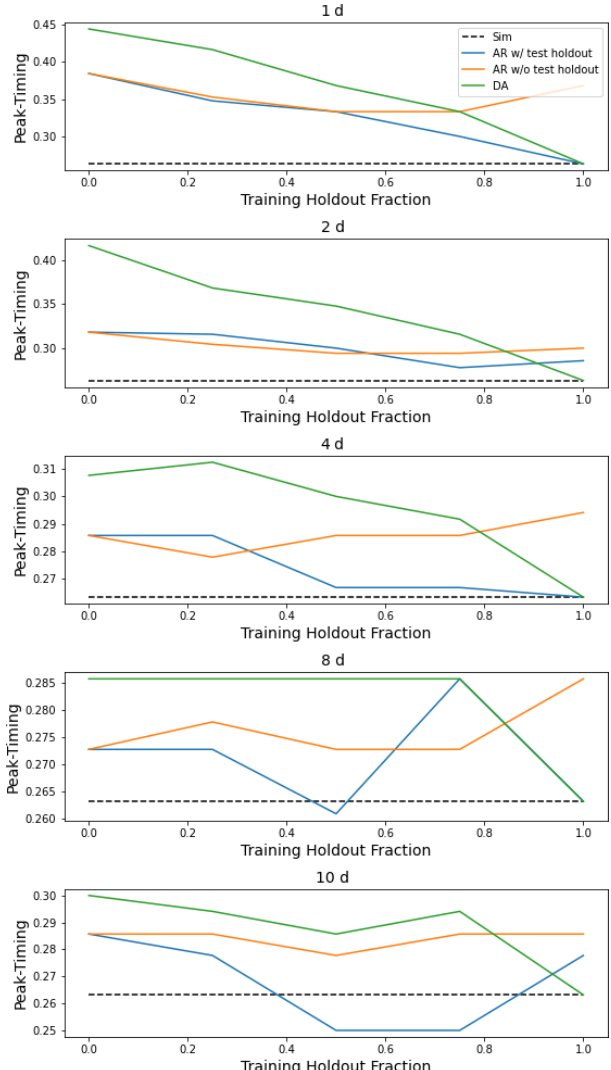
Figure H6. Same as Fig. 4 but for the fraction of missed peak flow events within 1d above 80th flow percentile (Appendix